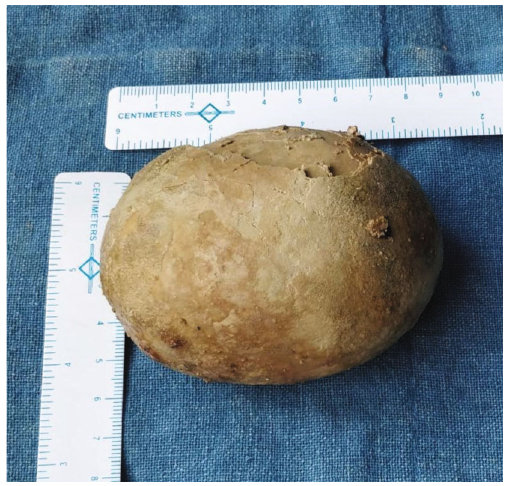
Figure 3: Size of bladder